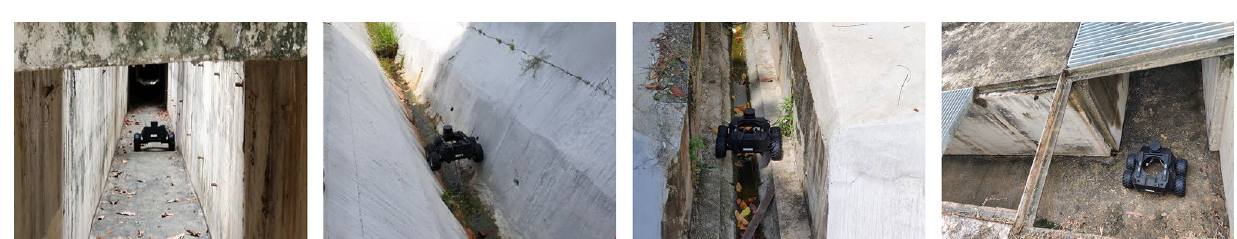
Figure 13. Raptor maneuverability test in different drain terrains.